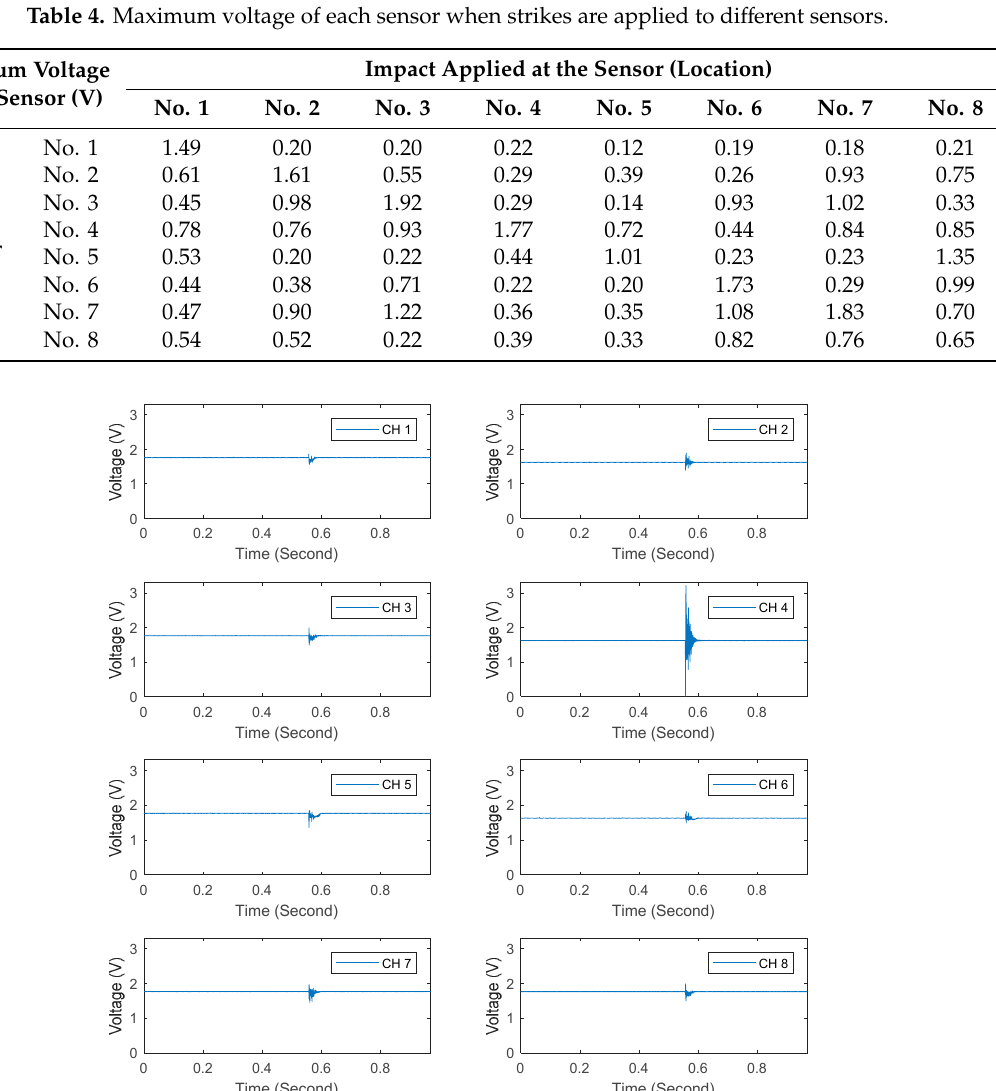
Figure 14. PZT sensor time-domain response signal (impact is introduced near No. 4 sensor).